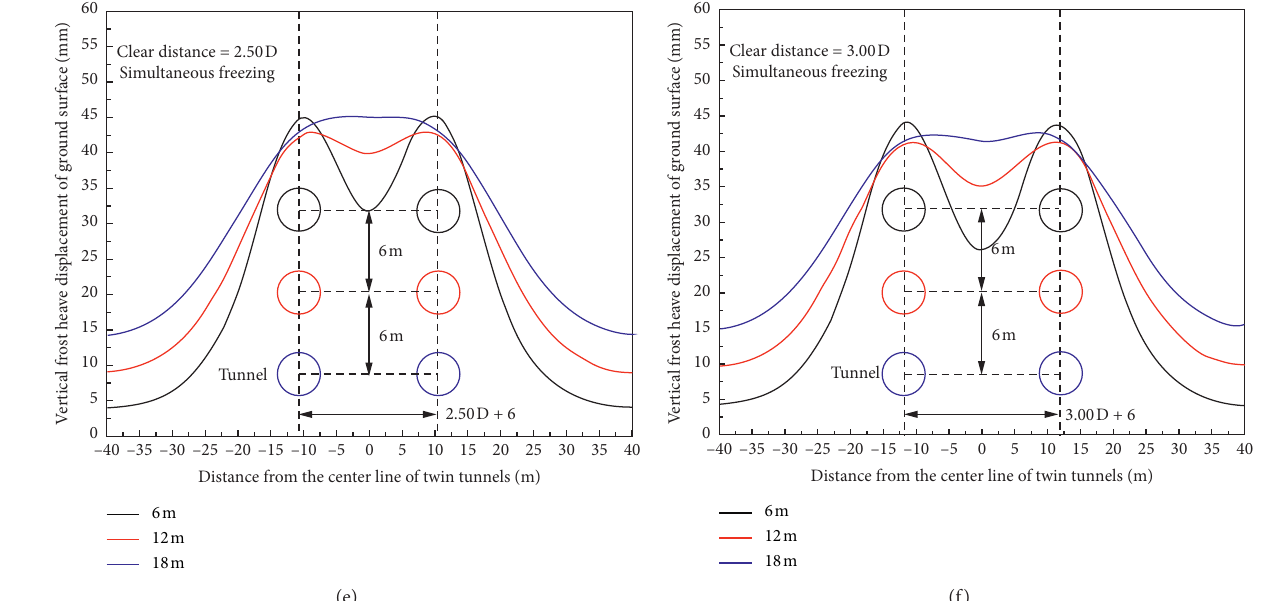
Figure 8: Heaving displacement of the ground surface.